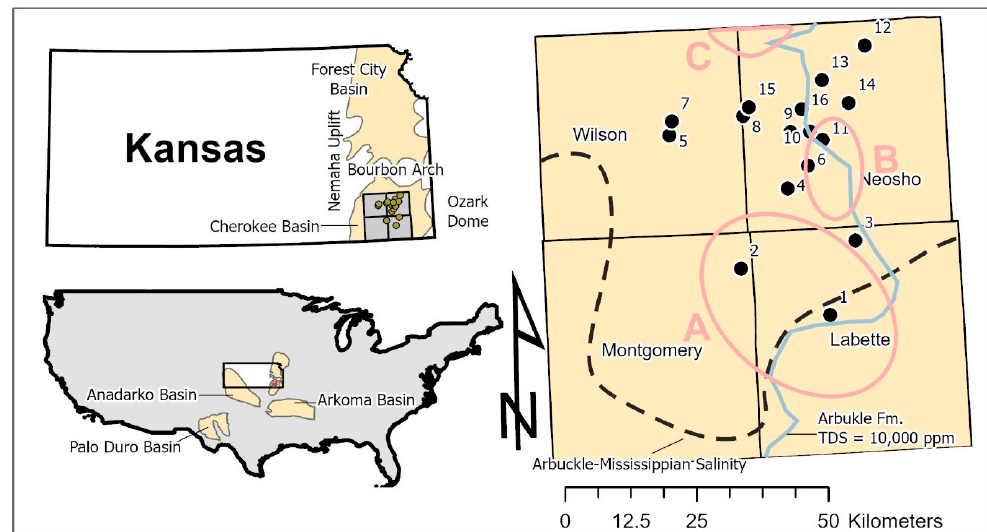
Figure 1. Study area location map. The study was completed within a four-county area in southeastern Kansas, USA, where 16 wells were sampled. Boundaries of the Anadarko, Arkoma, Cherokee, Forest City, and Palo Duro Basins are from Coleman Jr. and Cahan [57]. The Bourbon Arch separates the Cherokee and Forest City basins from each other, and the Nemaha Uplift is located immediately to their west. Circled areas A, B, and C refer to the Mound Valley, Galesburg, and Petrolia geothermal anomalies identified by Newell [46]. The solid grey line identifies location of the 10,000 ppm total dissolved solids (TDS) contour in the Arbuckle Gp [56], while the dashed black line identifies the approximate boundary where the underlying Arbuckle Gp. has a higher salinity than the overlying Mississippian [46]. In the deeper Arbuckle Gp., salinity is higher to the west of the grey line, and is higher than in the Mississippian to the south of the dashed line. Minerals 2021 , 11 , x FOR PEER REVIEW